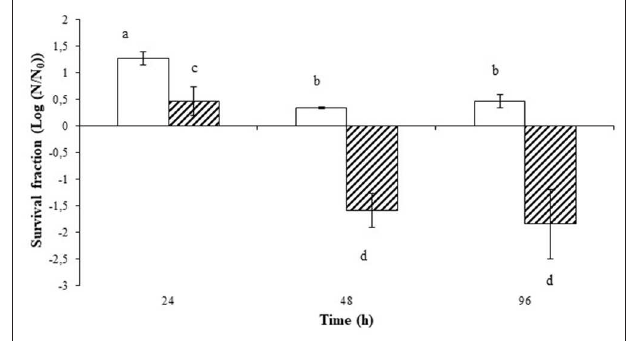
FIGURE 2 | Evolution of the microbial load of Salmonella in the intestine of C. elegans at 24, 48, and 96 h post-infection fed (stripped bar) and not fed (blank bar) with cauliflower extract. Survival of Salmonella Typhimurium in the intestine of C. elegans is expressed as survival fraction of Salmonella cells (CFU/mL) in the intestine of C. elegans (Log (N/N0)) at 24, 48, and 96 h post-infection fed and not fed with cauliflower extract. Different letters indicate significant differences in survival fractions ( p ≤ 0.05) and error bars represent standard